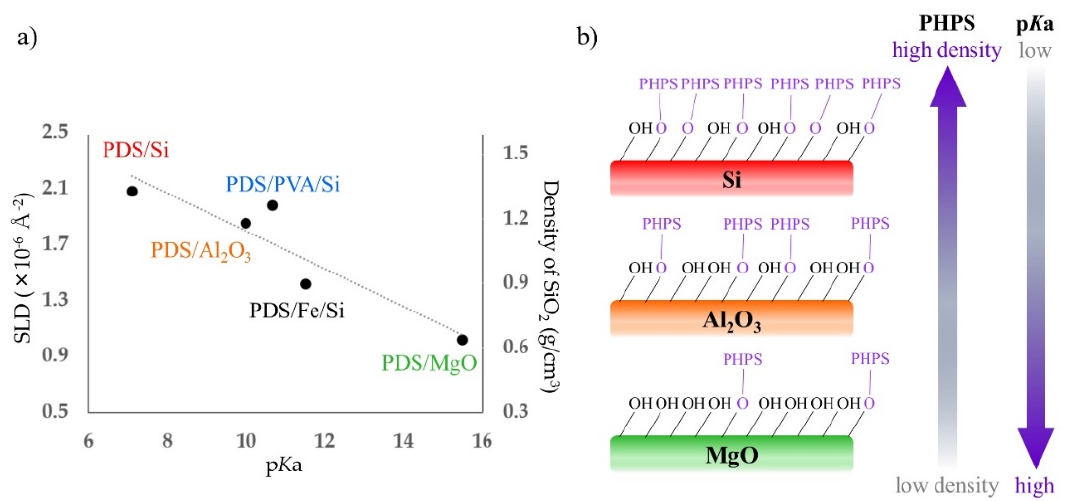
Figure 4. ( a ) Plot of p K a values of the substrate vs. scattering length density (SLD) values (or density of SiO 2 ) of the PDS thin layer. The PDS layer density as SiO 2 was calculated using the estimation method in reference 5. ( b ) Image of chemical bond formation between the substrate ‐ OH group and the PHPS polymer.